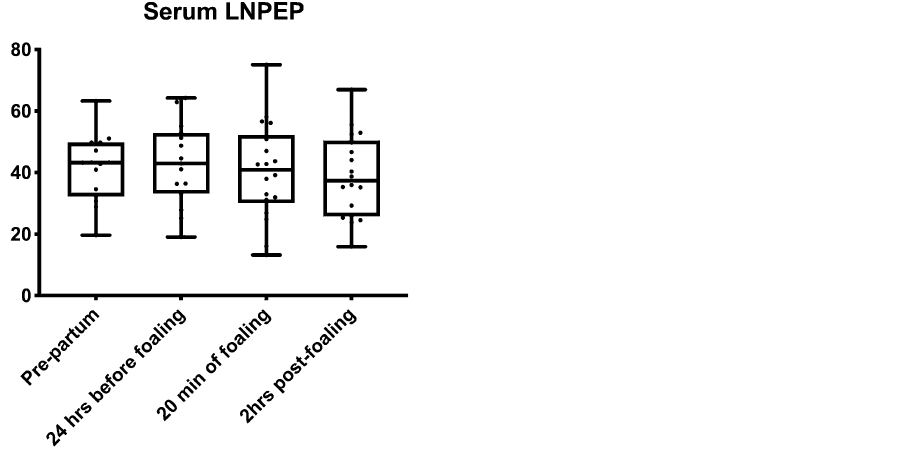
Figure 2. Median and interquartile (IQR) oxytocinase (LNPEP) (U/L) in mare serum (n = 18) pre-partum (around 320 days of gestation), 24 h before foaling, within 20 min of foaling and 2 h